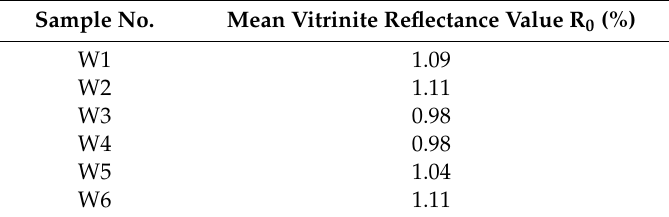
Table 2. Results of the measurements of the mean vitrinite reflectance value for the coal samples analyzed in the present